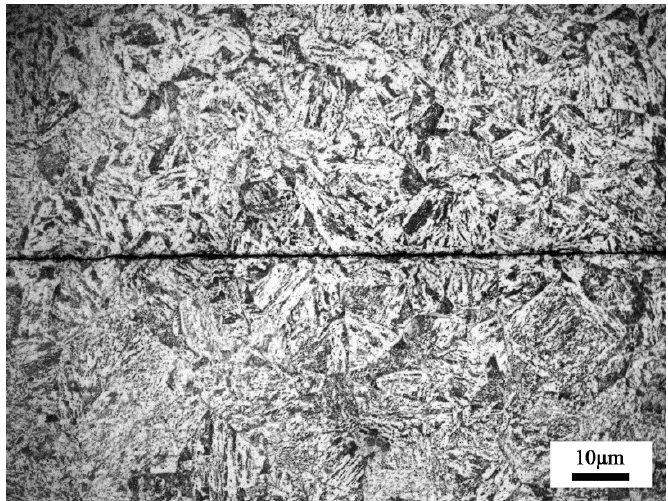
Figure 3. An optical micrograph of the pre-crack zone before the healing treatment.